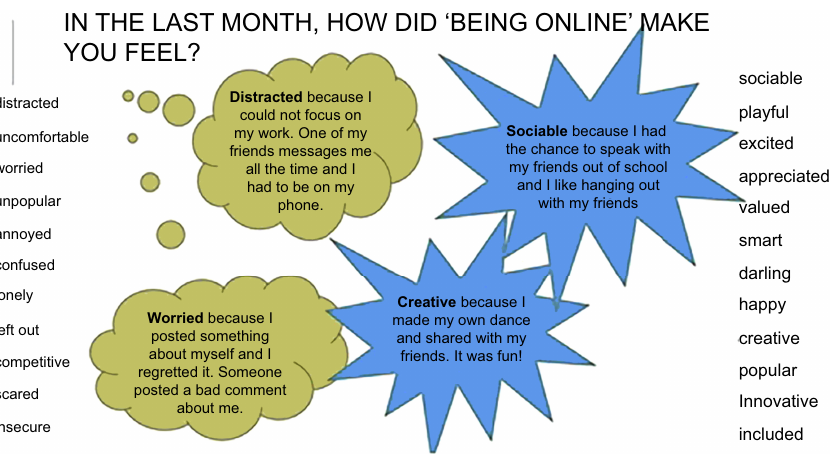
Figure 1. Clouds and stars ice-breaking